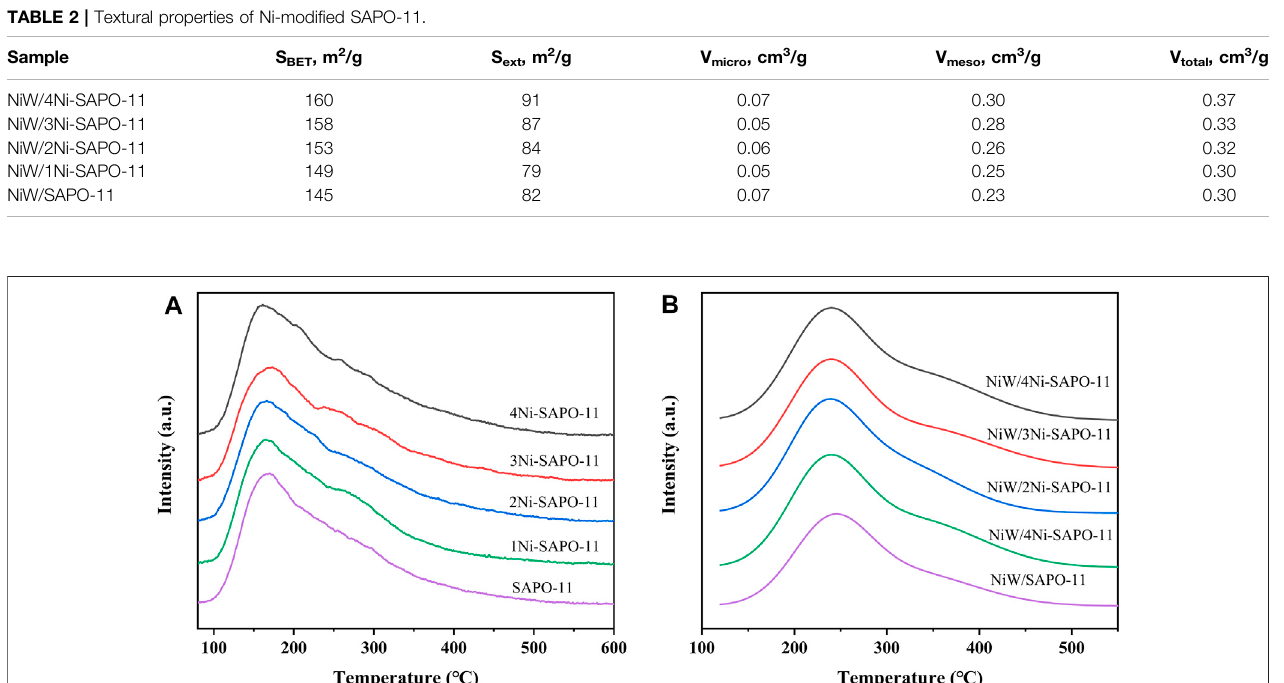
FIGURE 5 | NH 3 -TPD pro fi les of Ni-modi fi ed SAPO-11 molecular sieves (A) and different catalysts (B) .